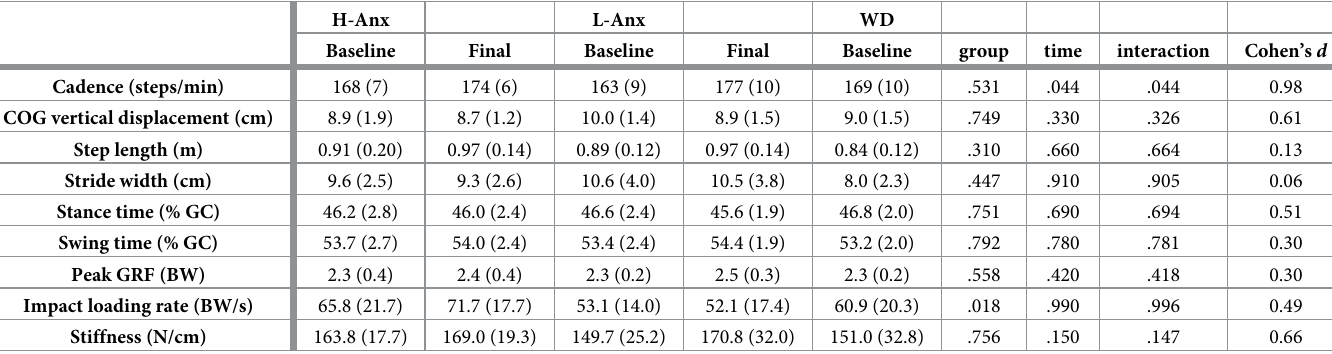
Table 3. Performance-based gait metrics in injured runners with and without high anxiety levels. Values are means (SD). H-Anx L-Anx WD Baseline Final Baseline Final Baseline group